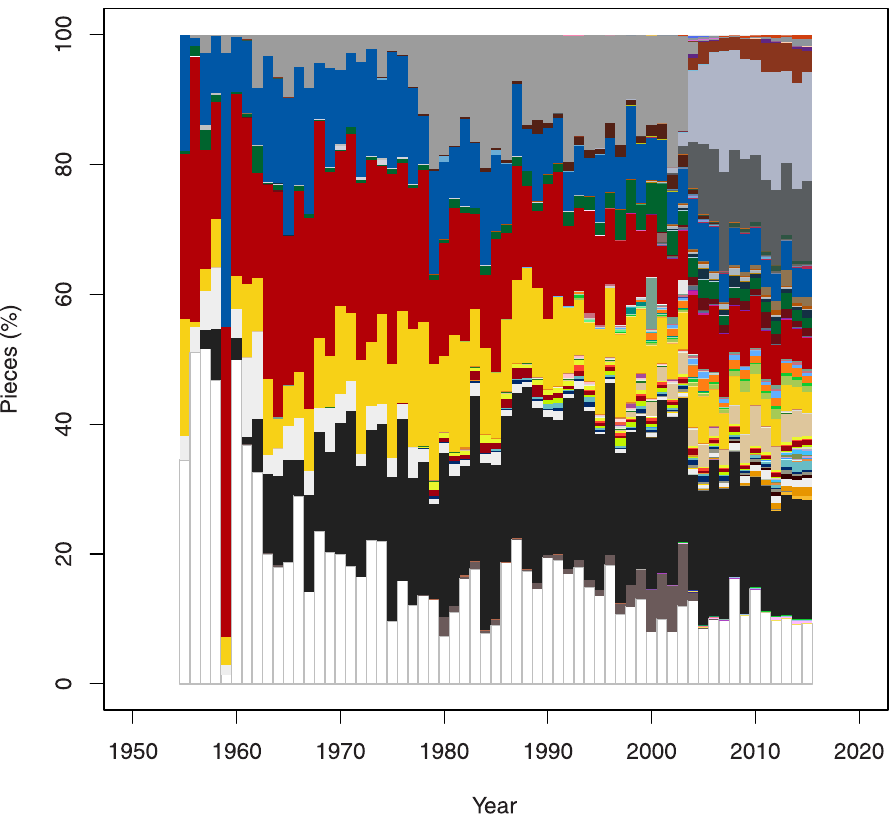
Fig 6. Relative frequencies of bricks colors across time. The x-axis indicates years.